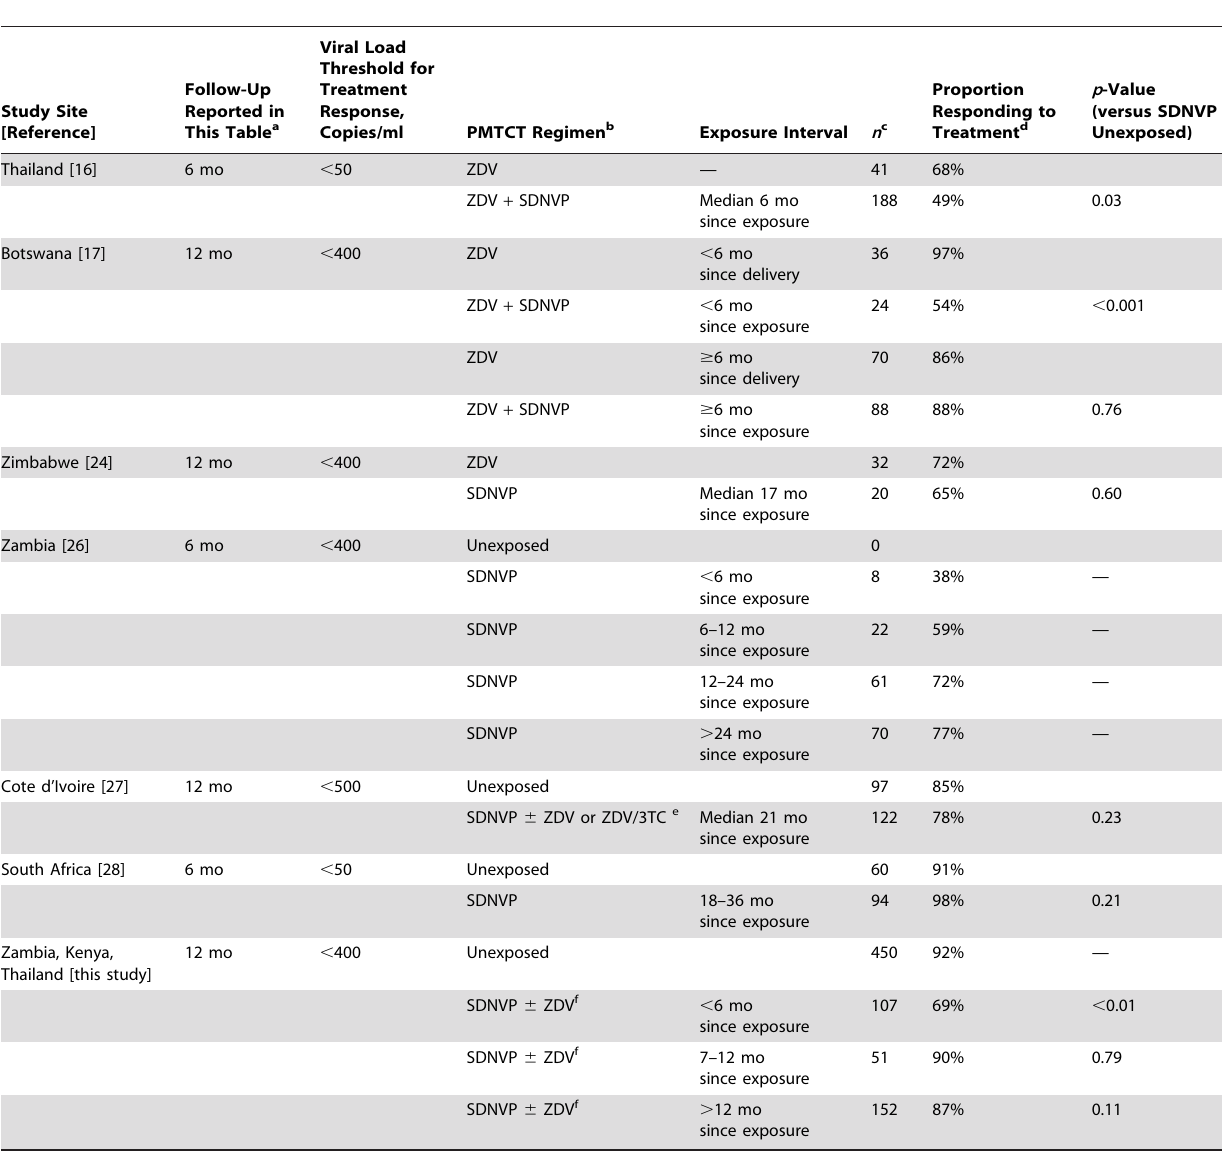
Table 5. Studies of virologic response rates to NNRTI-based treatment among women previously exposed to single-dose NVP.